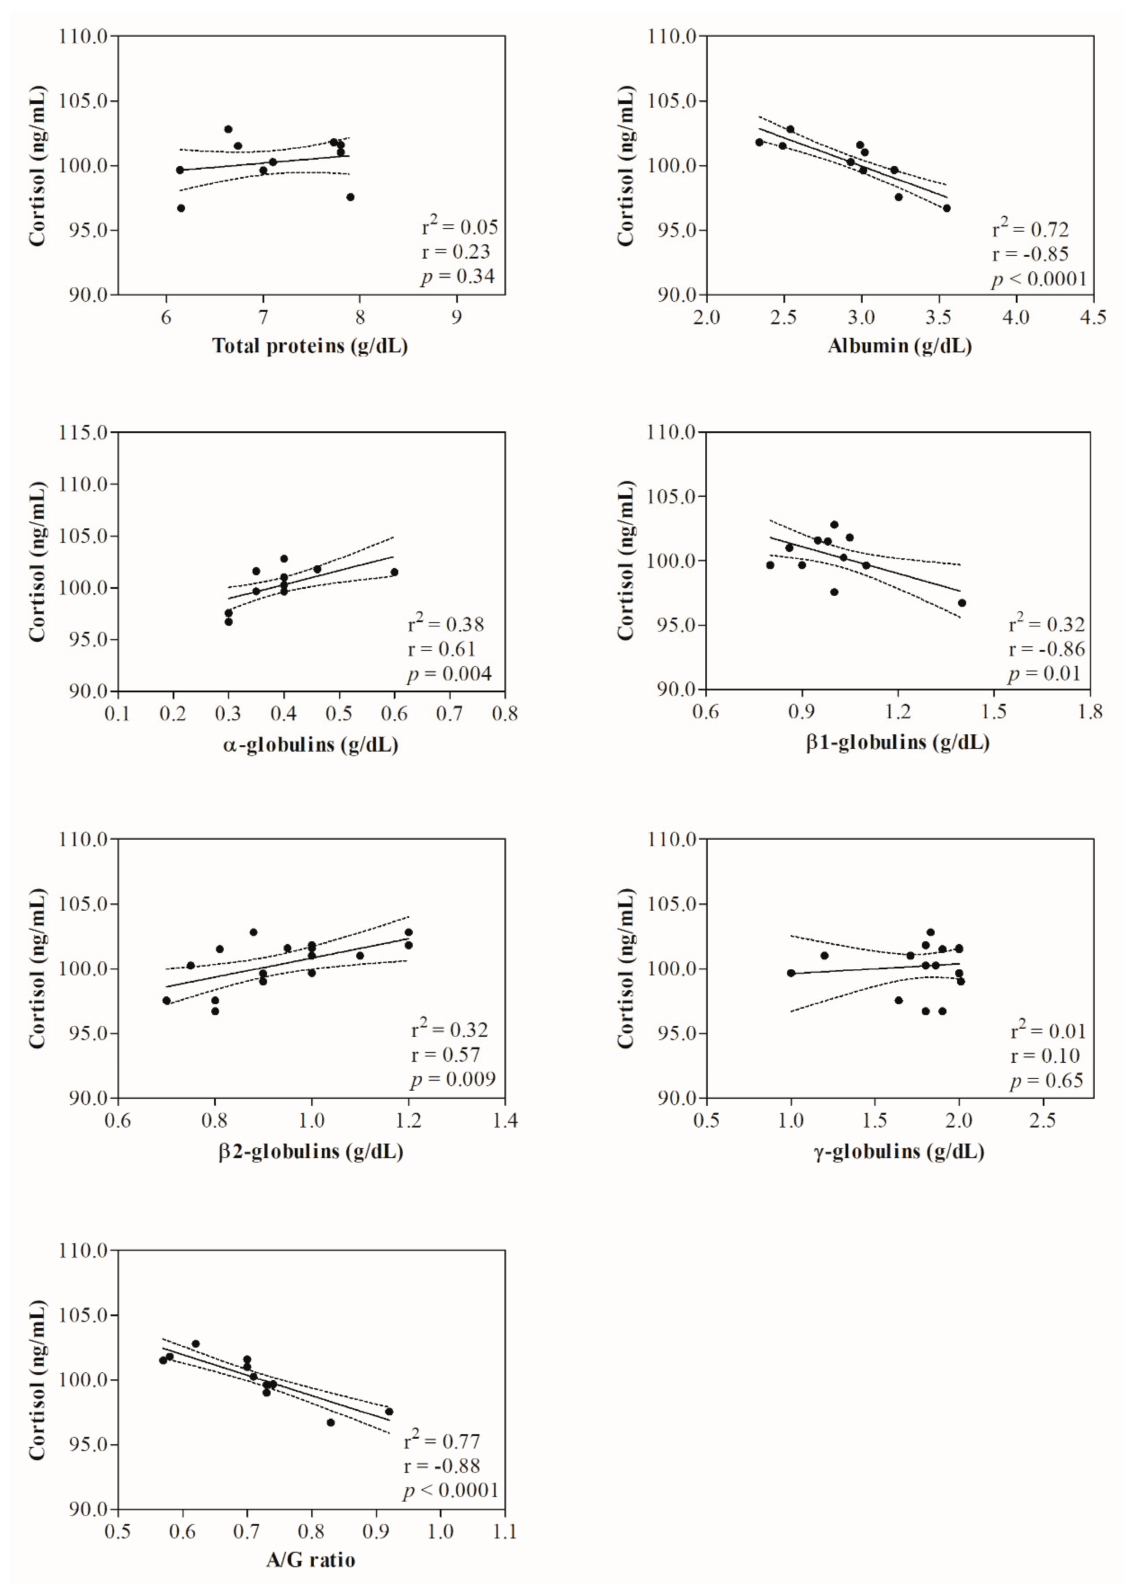
Figure 4. Linear regression model results found between the serum values of cortisol and the serum levels of serum total proteins, albumin, α -, β 1-, β 2-, γ -globulins and the A/G ratio measured in ewes after 60 min from the end of the shearing procedure (T POST60